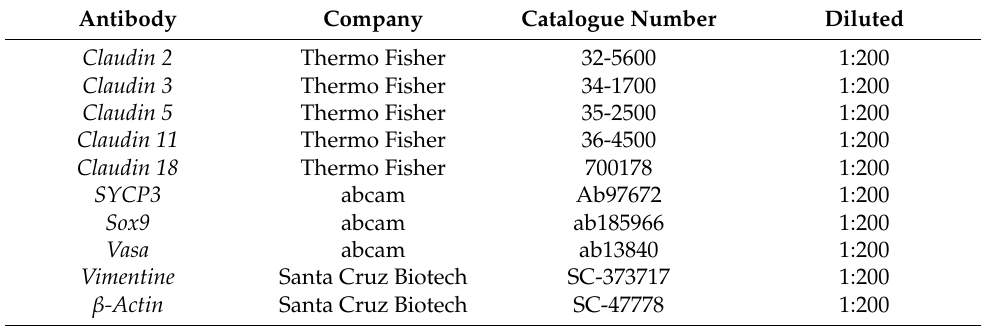
Table 1. List of antibodies used in immunostaining.